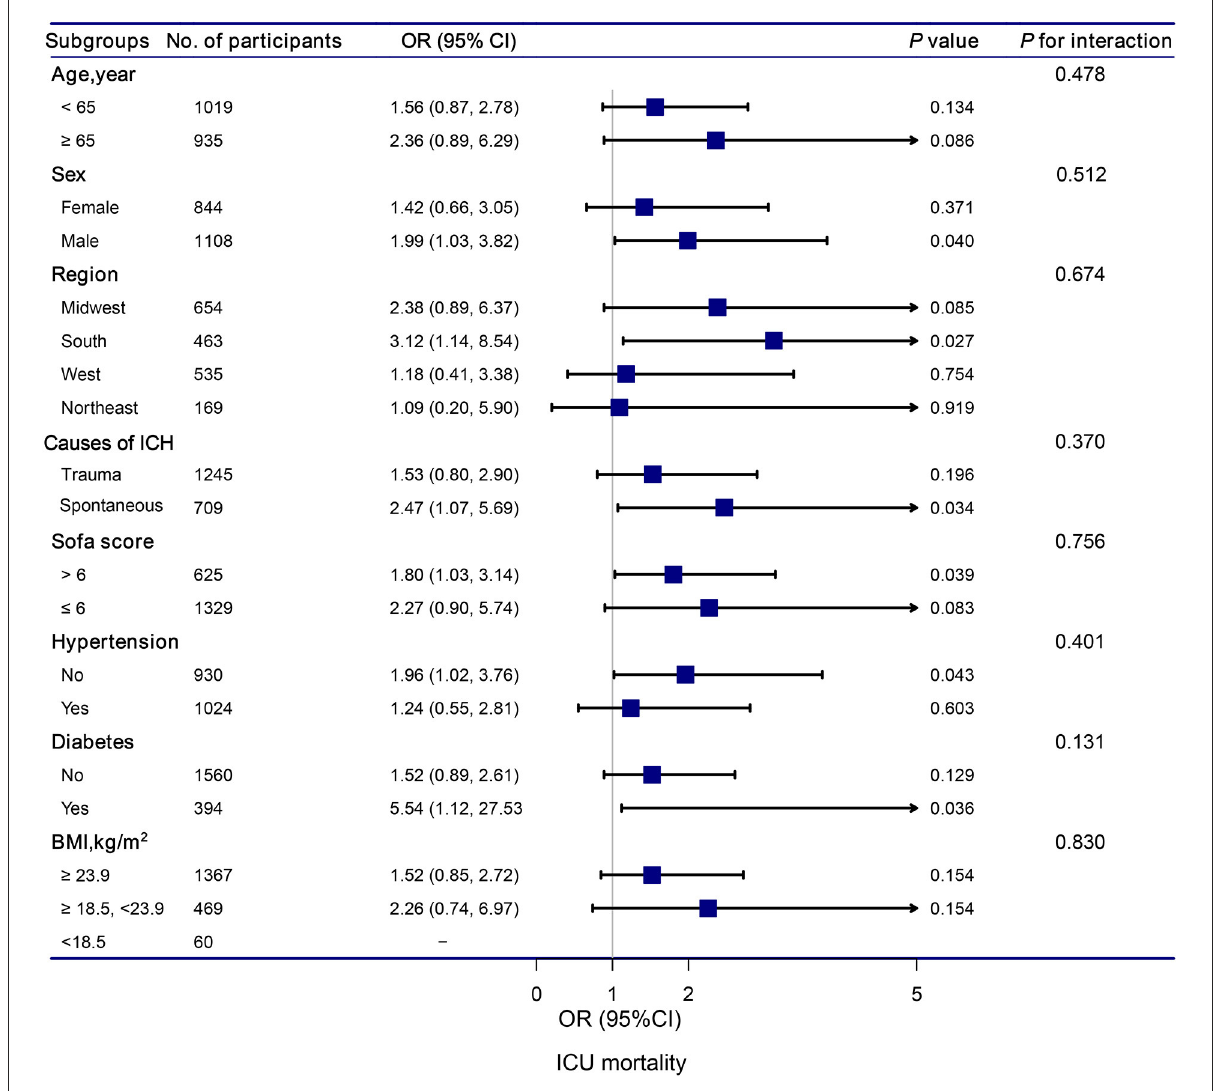
FIGURE3 Association between hypocalcemia and ICU mortality according to subgroup. Analyses were adjusted for gender, age, region, race, BMI, mean systolic, mean diastolic, white blood cell count, hemoglobin, platelet, glutamic-pyruvic transaminase, INR, prothrombin time, blood urea nitrogen, creatinine, magnesium, glucose, lactate, SOFA, trauma, first day vasopressor, first day sedative, hypertention, coronary artery disease, atrial fibrillation, congestive heart failure, diabetes, chronic pulmonary disease, and